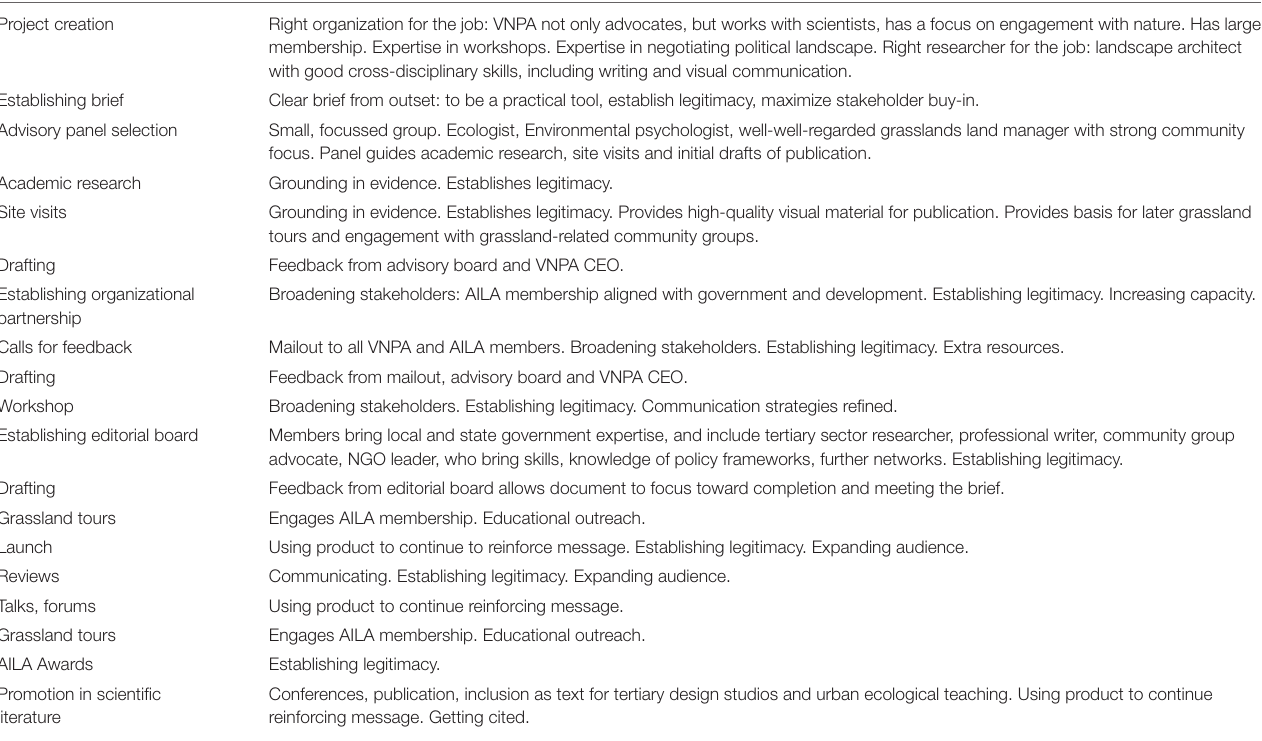
TABLE 1 | Chronological steps in SWTG ’s development and outcomes that contributed to project success. Project